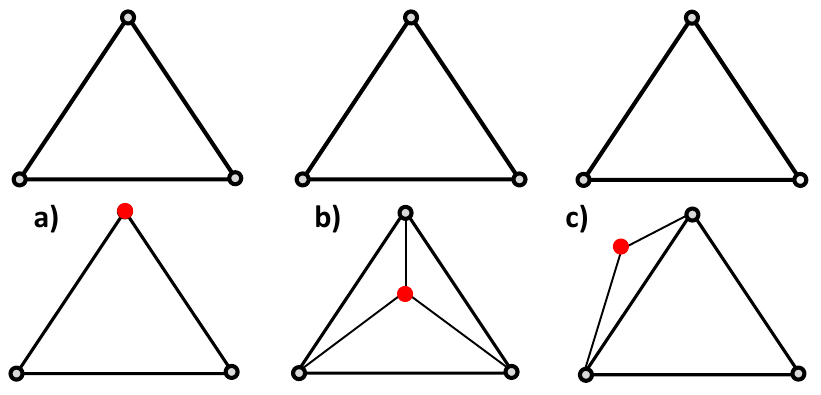
Figure 3. The possible cases in the output node positioning. The upper row corresponds to the input discretization and lower row to the output